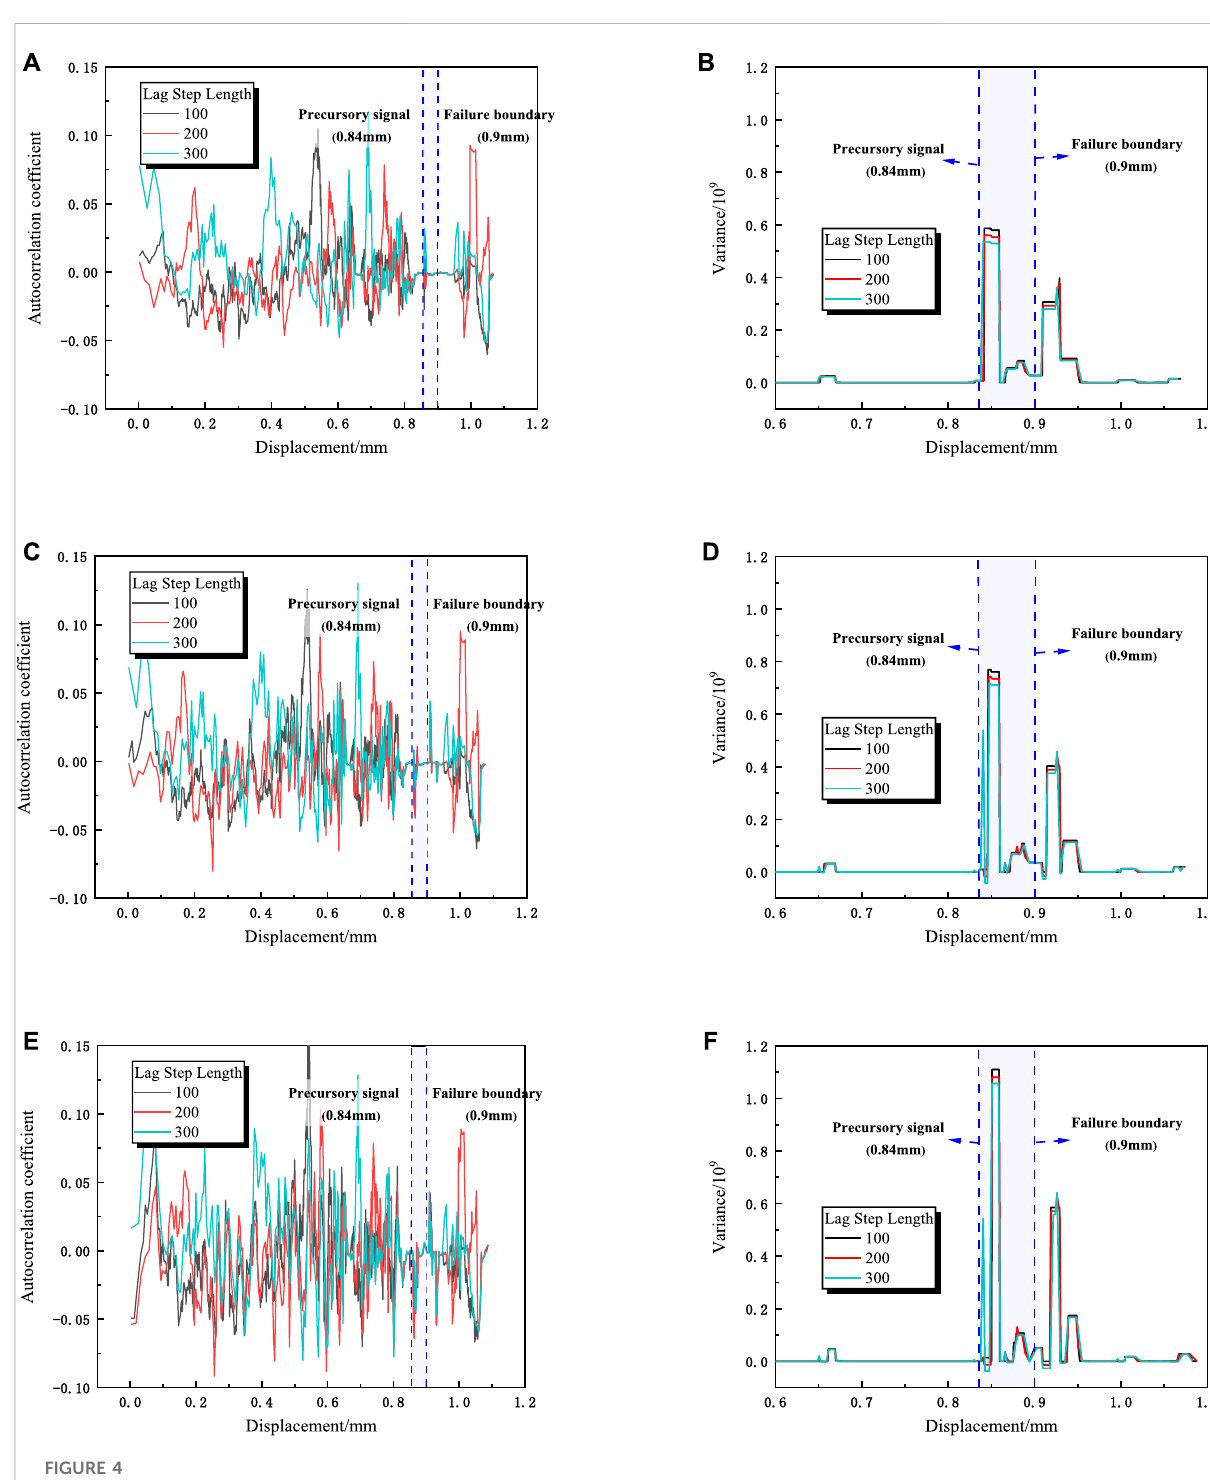
The self-correlation coef fi cient and variance variation characteristics of different lag steps (A,B) :window length 2000, (C,D) :window length 1,500, (E,F) :window length